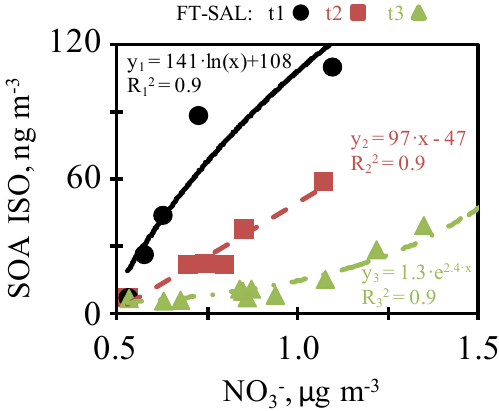
Figure 3. Scatter plot between SOA ISO and nitrate within the SAL under FT conditions (FT-PM T samples collected during the night). Three tendencies can be distinguished: tendency 1 (t1; cir- cles), tendency 2 (t2; squares) and tendency 3 (t3; triangles). West- erlies were excluded when calculating the regression coefficients as values were under the detection